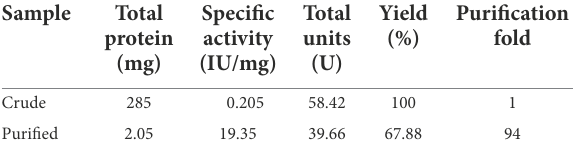
TABLE 1 Protein purification of recombinant β -1,4-glucanase using HisPur Cobalt superflow resin. Sample